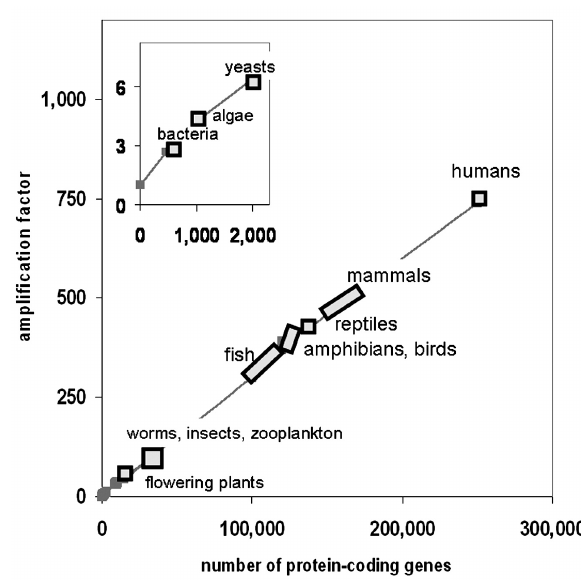
F IG . 2. – Relationship diagram for different life forms, concerning their number of protein coding genes and their amplification factor, used by Jørgensen (“Integration of Ecosystem Theories: A Pattern” second revised edition of 1997, 388 pp. Kluwer Academic Publisher, Dordrecht), to calculate the contribution to “exergy” storage in the ecosystem. The procedure consists of multiplying this amplification factor with the calorimetric free energy content of the corresponding biomass (18.7 kJ/g). See text for explanation. Note the insert used for the lower values of the more primitive life